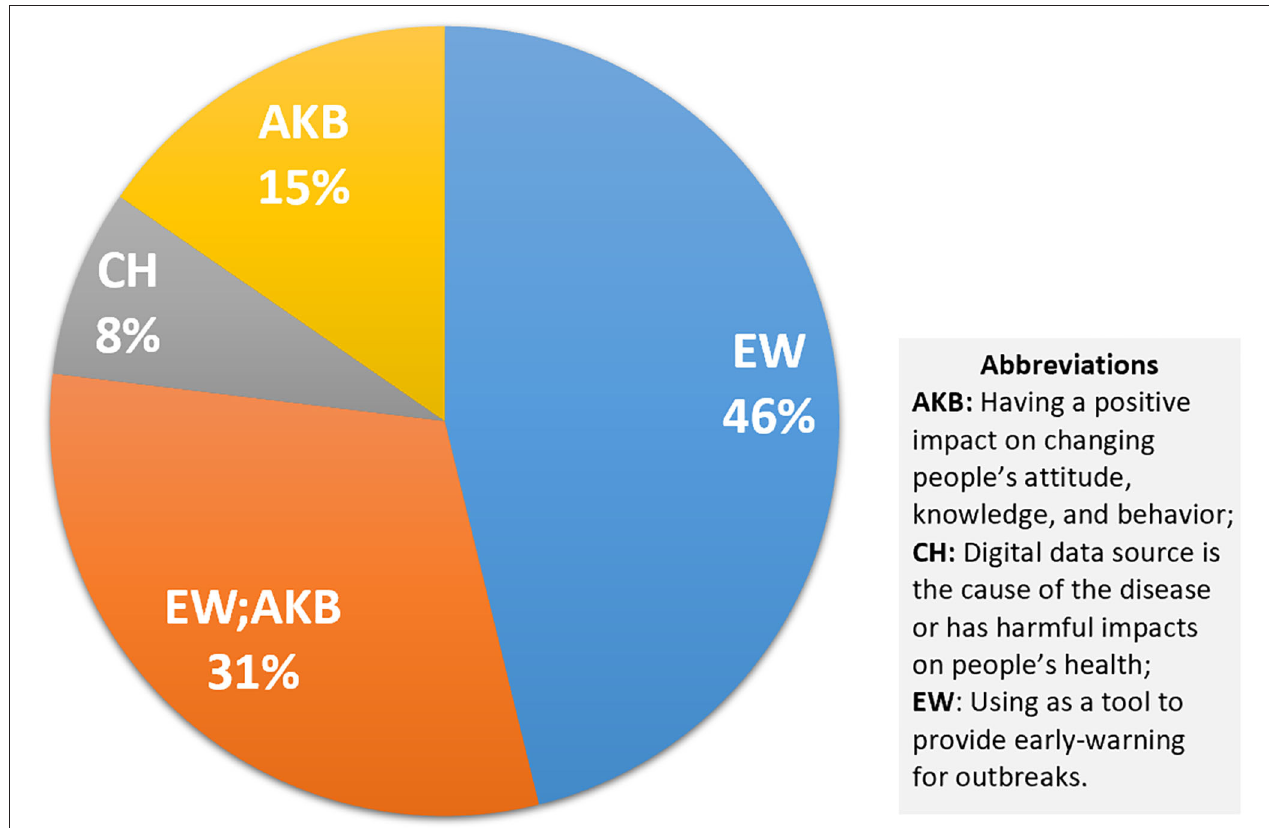
FIGURE 6 | Pie chart showing the impact of digital data sources on health